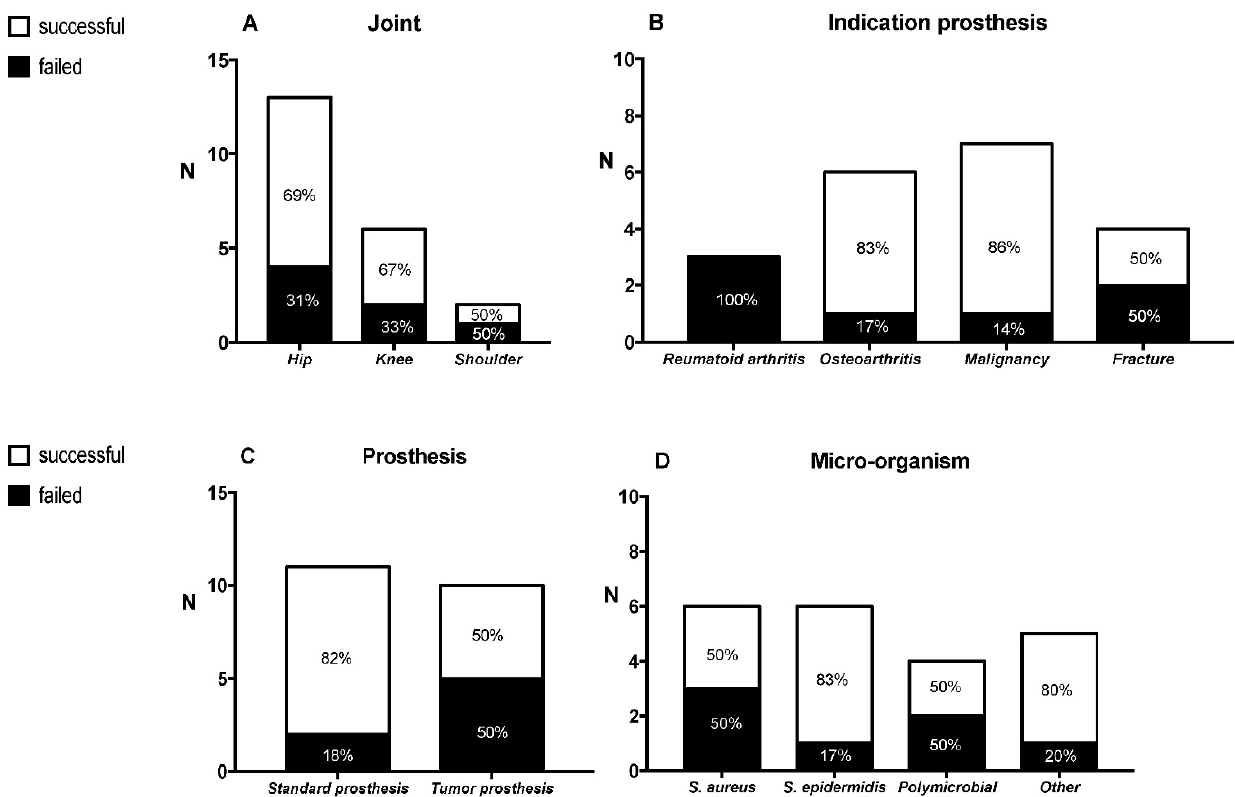
Figure 1 . Outcome of antibiotic suppressive therapy (n=21) subdivided in several parameters; the affected joint (A), the indication for the prosthesis / underlying condition (B), the type of prosthesis (C) and the causative pathogen / micro-organism for the prosthetic joint infection (PJI) (D). The definition of successful treatment and failed treatment is descripted in the